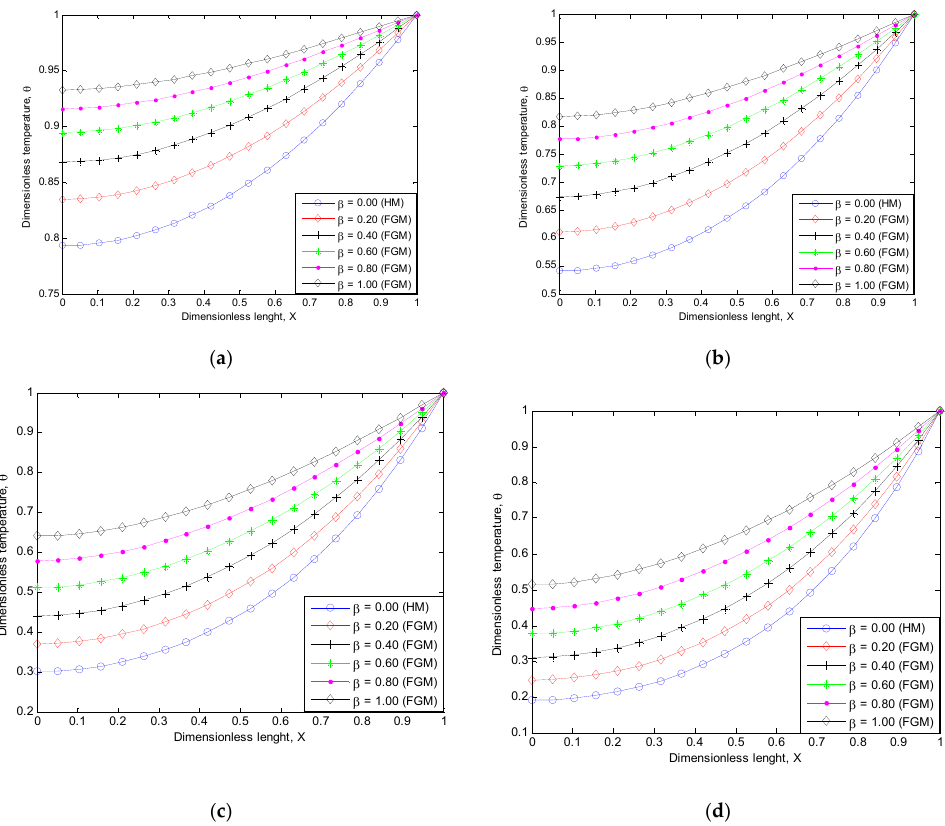
Figure 5. Fin dimensionless temperature profile for varying thermo ‐ geometric parameter under power ‐ law function when: ( a ) Nc = 0.0, Ra = 0.01, Nr = 0.5; ( b ) Nc = 0.1, Ra = 0.01, Nr = 0.6; ( c ) Nc = 1.0, Ra = 0.01, Nr = 0.1; and ( d ) Nc = 2.0, Ra = 0.01, Nr = 0.2.